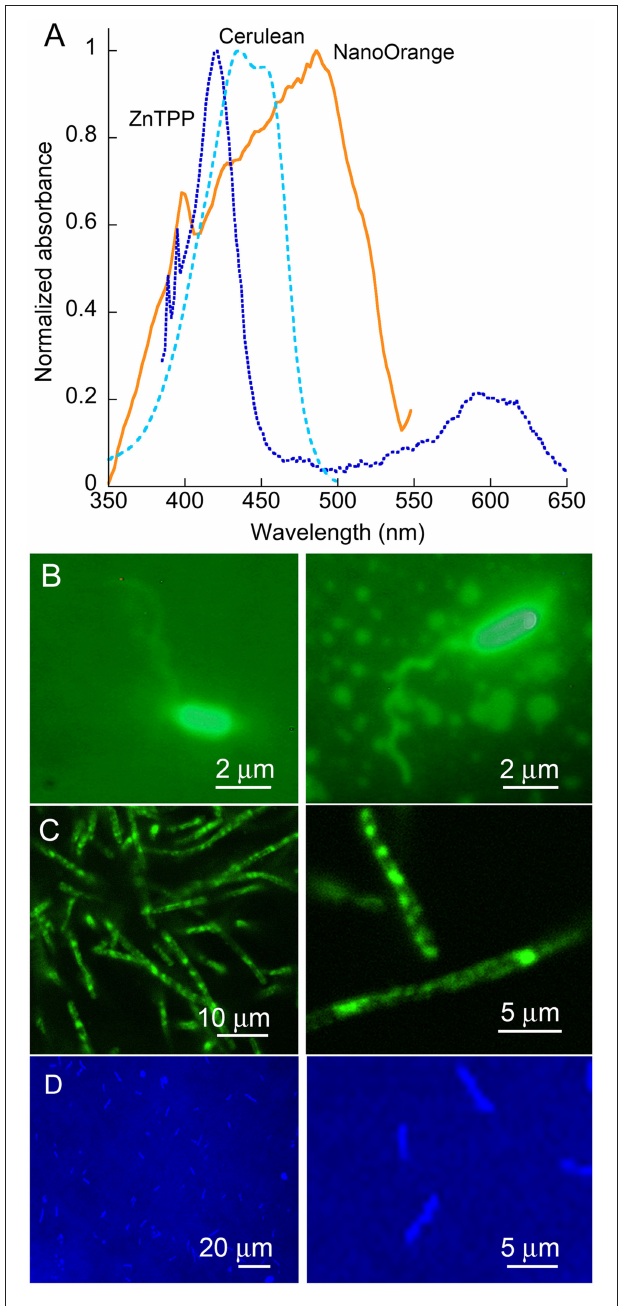
FIGURE 2 | Dyes and organisms used.(A) Absorbance spectra of the two dyes and one fluorescent protein used in this work. Note the strong Soret band of the porphyrin ZnTPP, and the broad absorbance of NanoOrange. (B) Epifluorescence images of V. alginolyticus labeled with NanoOrange. (C) Epifluorescence images of B. subtilis labeled with NanoOrange. Labeling patterns with ZnTPP were similar (not shown). (D) E. coli expressing the Cerulean fluorescent